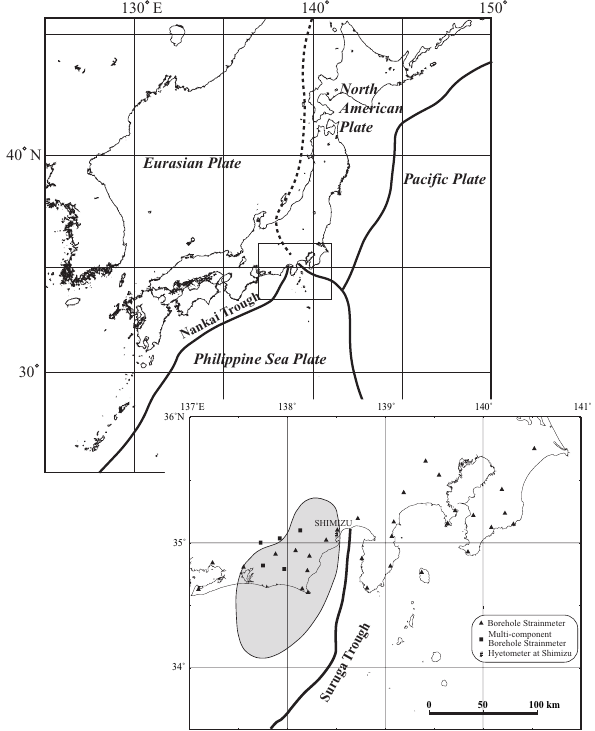
Fig. 1. Locations of strainmeter in Tokai and South Kanto Re- gion. They have been operated by Japan Meteorological Agency (JMA) and the Government of Shizuoka Prefecture. A grey ellipse in the lower figure shows the most up-to-date “expected focal re- gion” of the Tokai Earthquake. (http://www.seisvol.kishou.go.jp/ eq/hantekai/q1/q1.html).